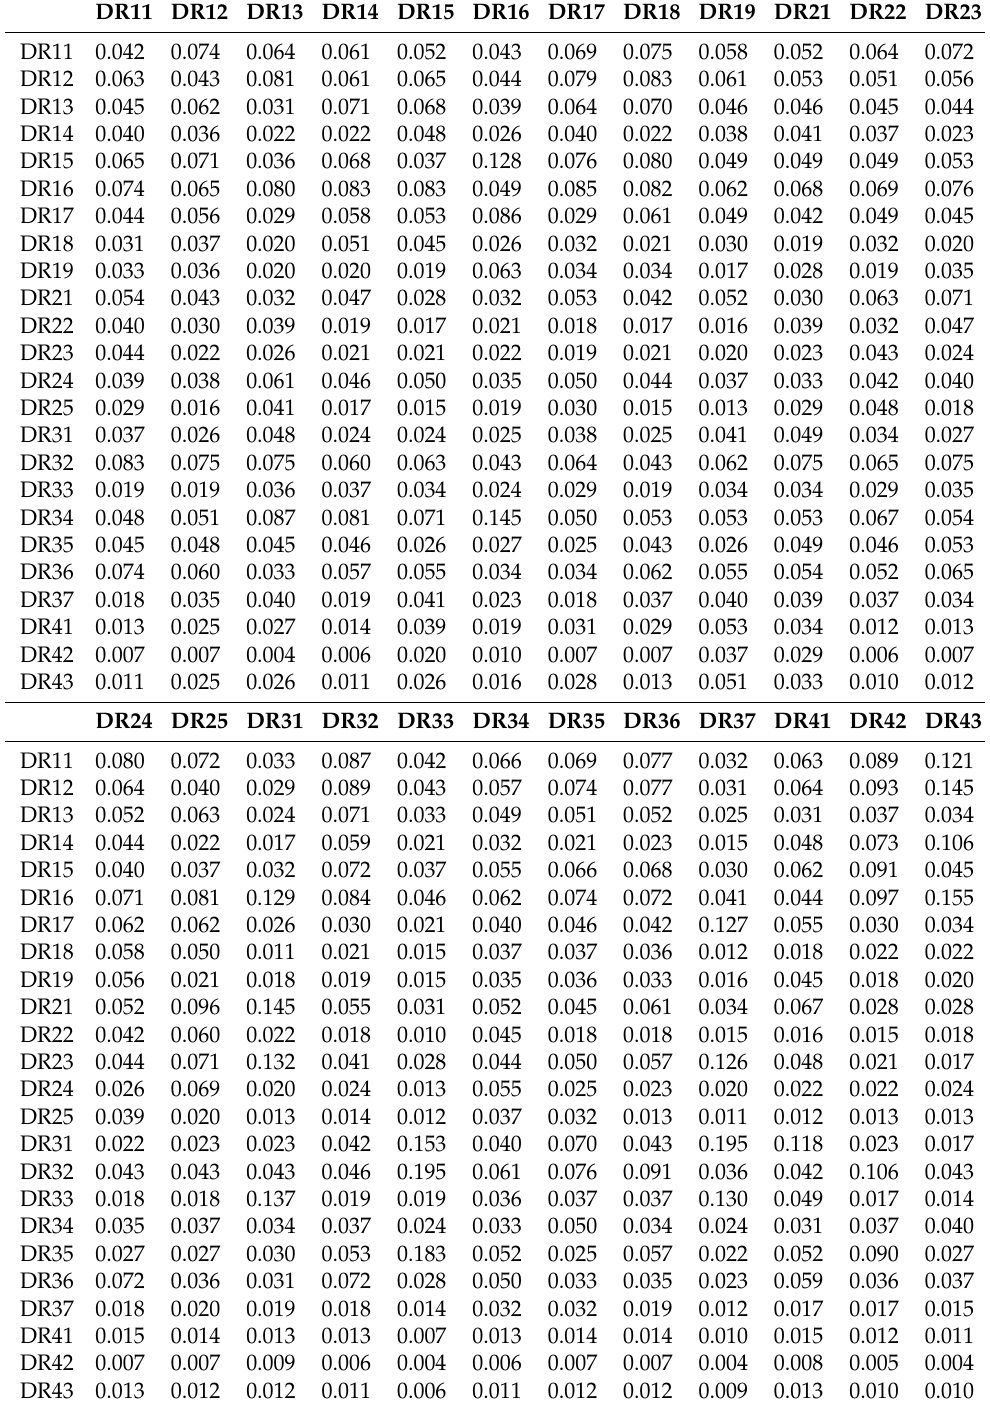
Table 9. Normalized autocorrelation matrix W 3 of